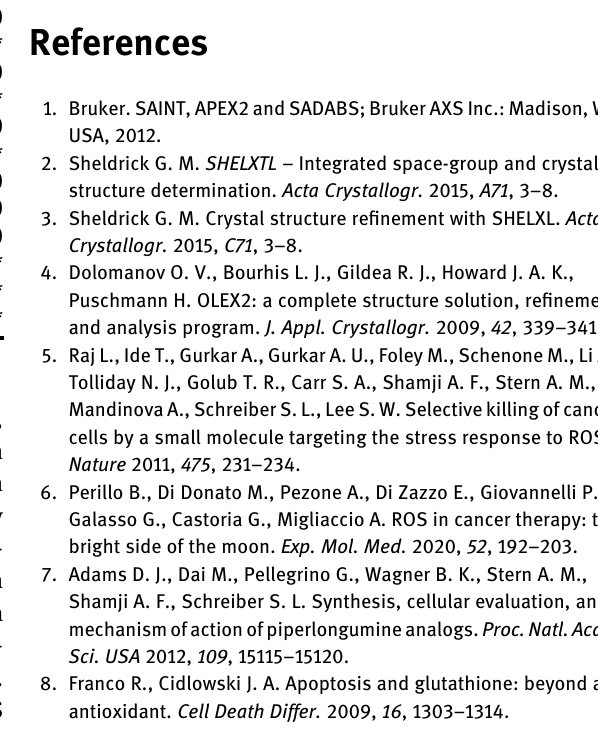
In the title compound, the C2=C3 double bond adopts a